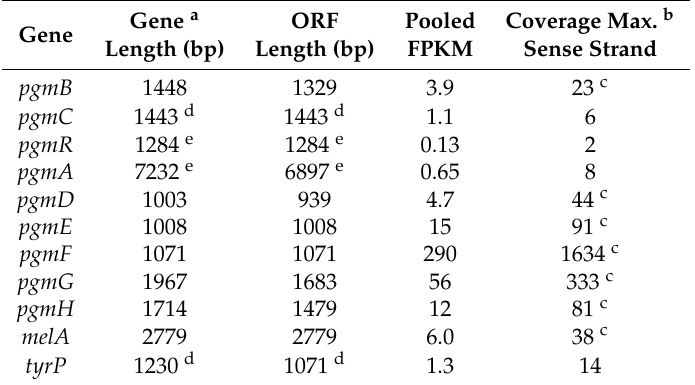
Table 1. Information on the A. terreus pgm gene cluster and the DOPA type melanin genes. Gene a ORF Pooled Coverage Max. b Gene Length (bp) Length (bp) FPKM Sense Strand pgmB 1448 1329